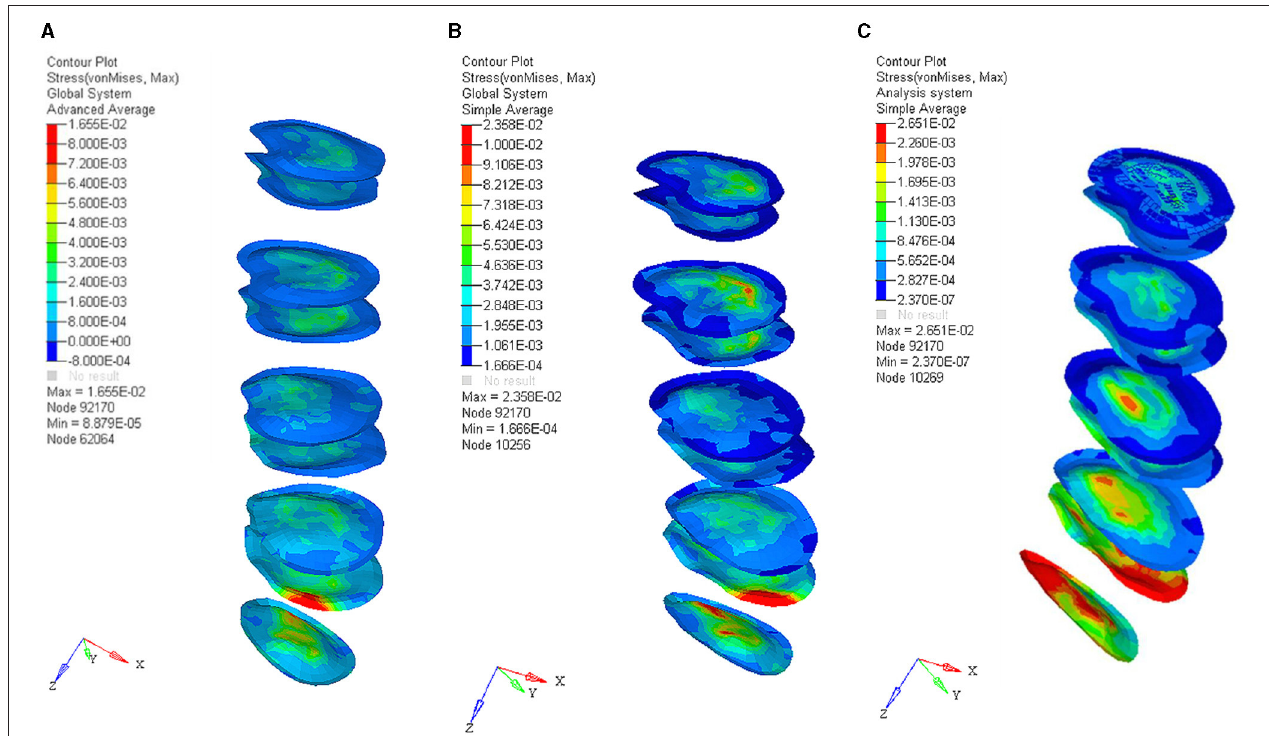
FIGURE 6 | The effective stress of endplate cartilage in bending without lifting weight posture (A) , the bending with lifting 3-year-old child posture (B) , and upright with 3-year-old child posture (C)